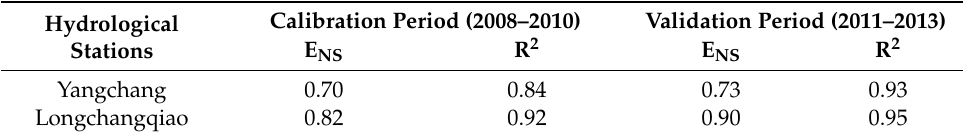
Table 1. E NS and R 2 of model performance at di ff erent monitoring